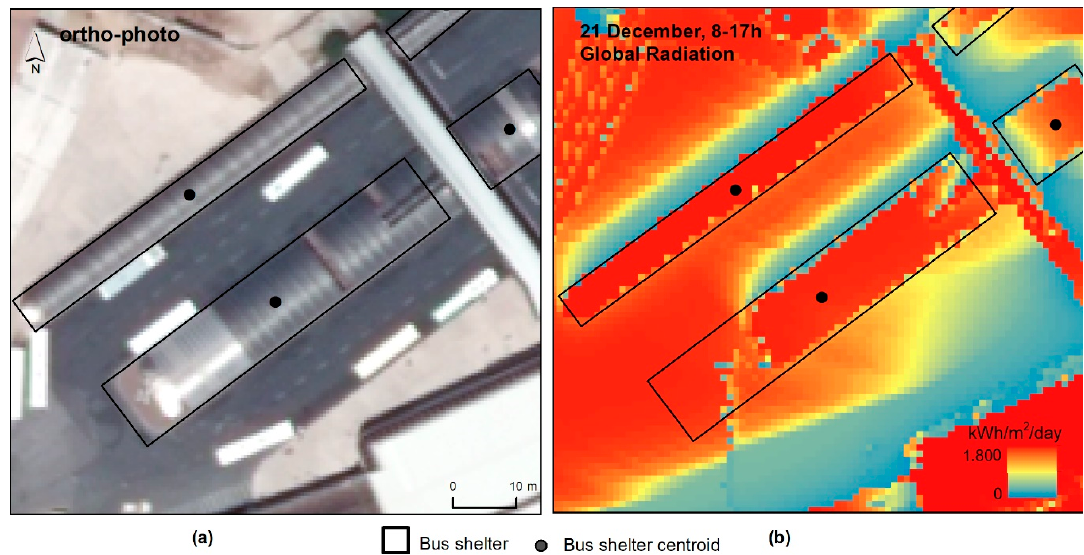
Figure 5. Map of the Global Radiation for the 21st December ( a ), and a neighborhood close-up ( b ).